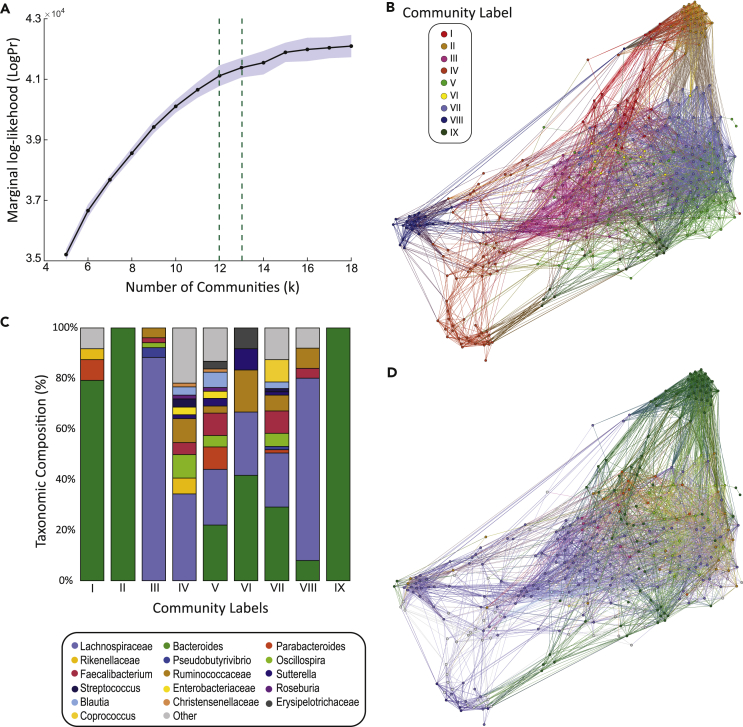
Bayesian Model Selection Using the Weighted Stochastic Block Model to Define the Microbial Interaction Network(A) We fit the WSBM algorithm across a number of models between k = 5 to k = 18, repeated 65 times each. The consensus partition, k = 12 (green, dashed), was achieved when mean marginal log likelihood, LogPr (blue, solid) plateaus.(B) Co-occurrence microbial interaction network, where each node represents an OTU and edges represent pairwise abundance relationships between them. The co-occurrence network has been reduced for visualization, representing 370 nodes and 4,854 edges at a Pearson correlation cutoff of r = 0.3. OTUs are colored according to community label.(C) Composition (%) of each community based on taxonomic assignment of the OTUs at the family/genus level.(D) The same co-occurrence network as seen in (B), but where OTUs have been colored according to taxonomic assignment at the family/genus level.